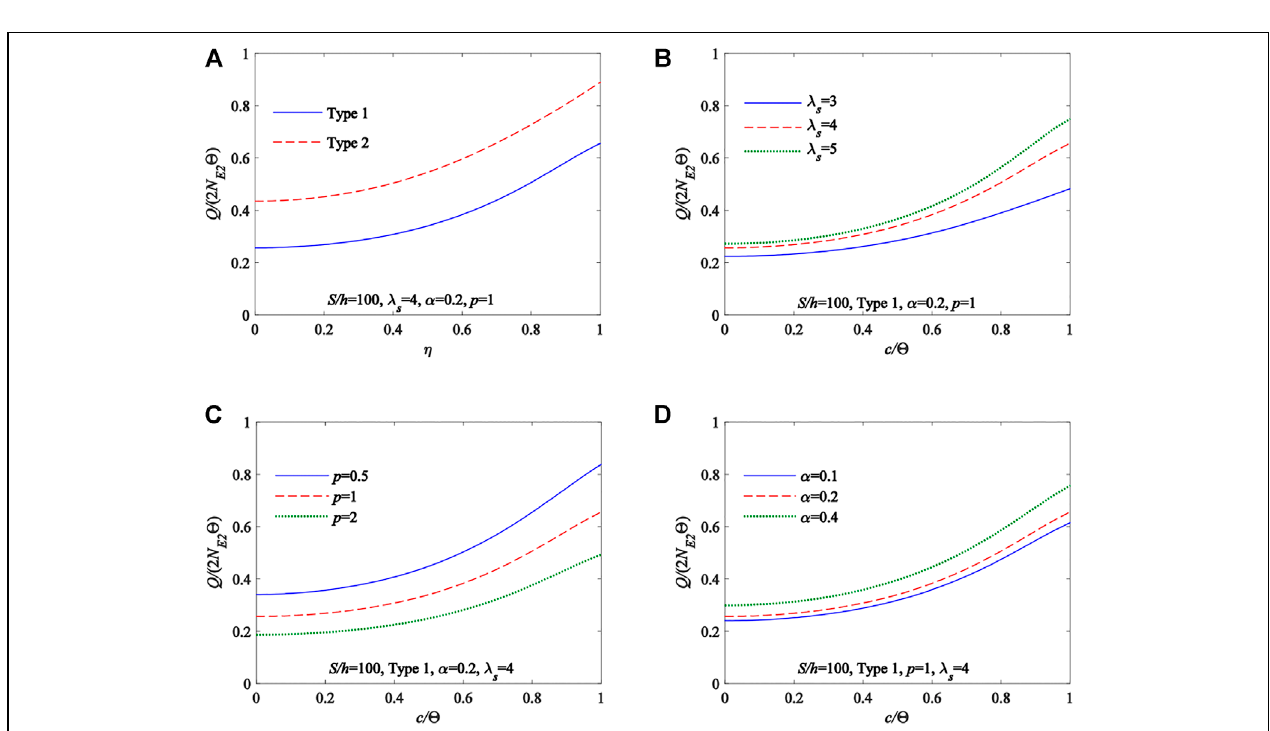
FIGURE 3 | Equilibrium paths of limit point instability for pin-ended FGM arches using different types of cross-section: (A) v / f − Q /(2 N Ec 2 Θ ) curves. (B) N / N Ec 2 − Q /(2 N Ec 2 Θ ) curves.